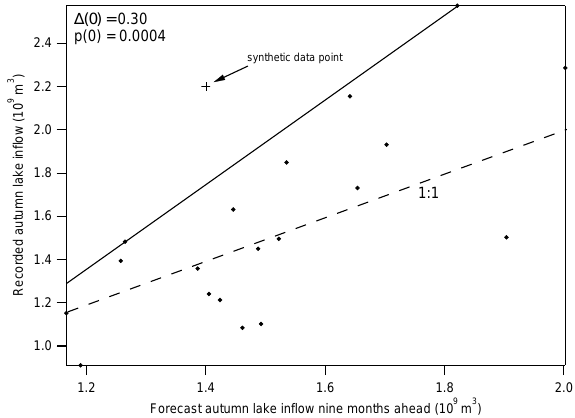
Fig. 2. Validation plot for a model forecasting combined autumn river inflow volumes into Lakes Tekapo and Pukaki (New Zealand).